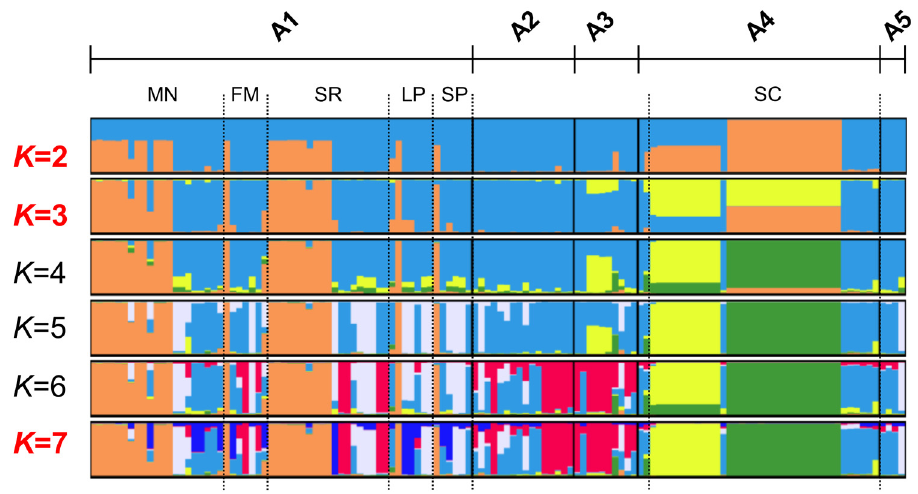
Fig 6. Genetic clustering analysis by STRUCTURE. The graph depicts the clustering models when the isolates were assigned into 2 to 7 clusters ( K = 2, 3 and 7 being the best models). Each isolate is represented by a single vertical line broken into K coloured segments, with lengths proportional to each of the K inferred